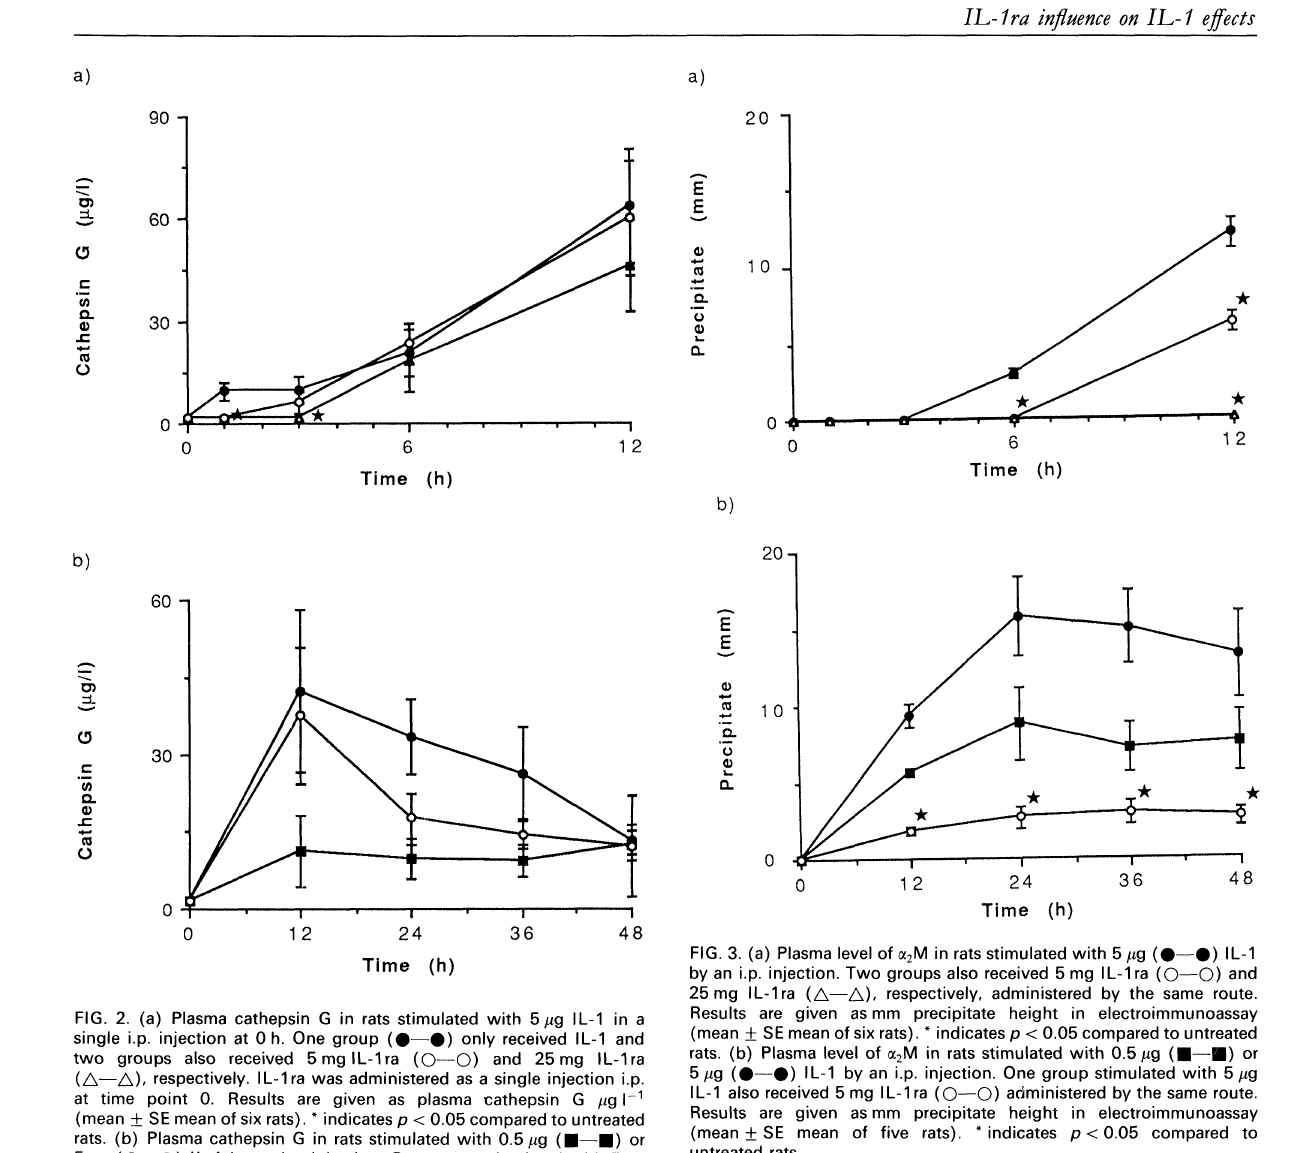
_ FIG. 2. (a) Plasma cathepsin G in rats stimulated with 5#g IL-1 in a single i.p. injection at 0 h. One group (0--0) only received IL-1 and two groups also received 5mg IL-lra (O--C)) and 25mg IL-lra (/--/), respectively. IL-lra was administered as a single injection i.p. at time point 0. Results are given as plasma cathepsin G #g 1-1 SE mean of six rats). indicates p < 0.05 compared to untreated (mean rats. (b) Plasma cathepsin G in rats stimulated with 0.5 #g (--.) or FIG. 4. Plasma level of ll3 in rats stimulated with 0.5 #g (,--) or 5 #g (--) IL-1 by an i.p. injection. One group stimulated with 5 #g IL-1 also received 5 mg IL-lra (O--O) administered by the same route. Results are given as mm precipitate height in electroimmunoassay (mean +_ SE mean of five rats).